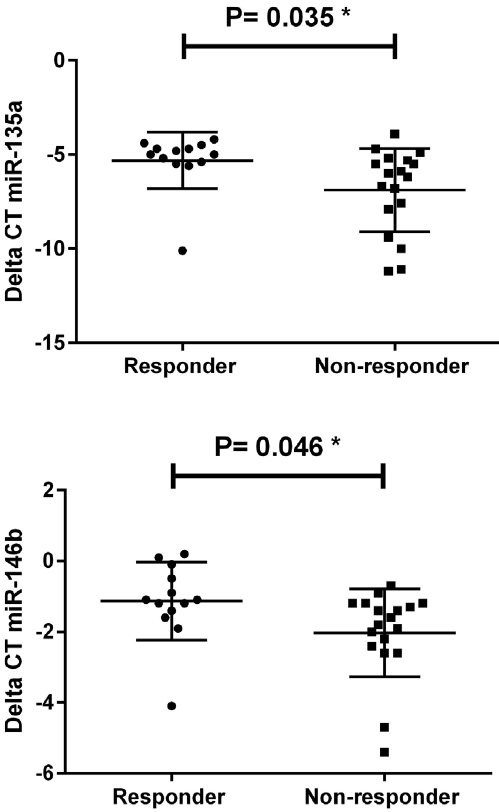
Figure 2 - miRNAs significantly deregulated in response to treatment in